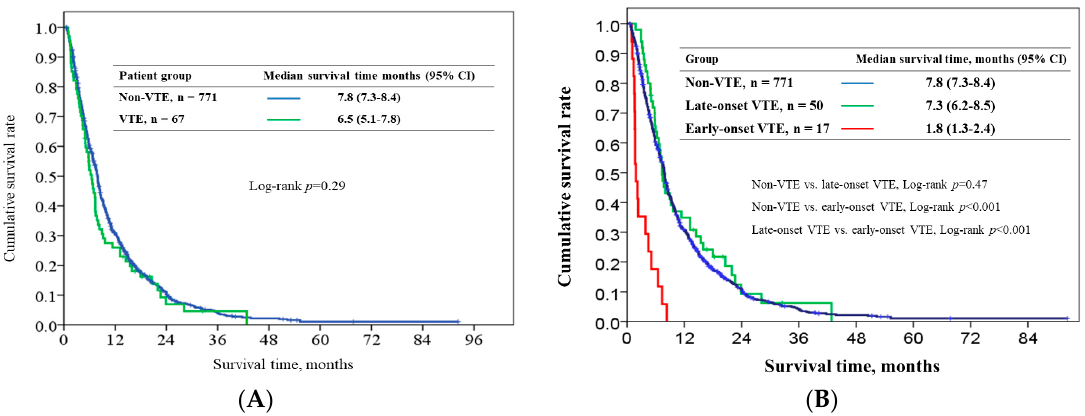
Figure 4. Survival outcome in VTE and non-VTE patients ( A ) and in early-onset, late-onset, and non-VTE patients ( B ).